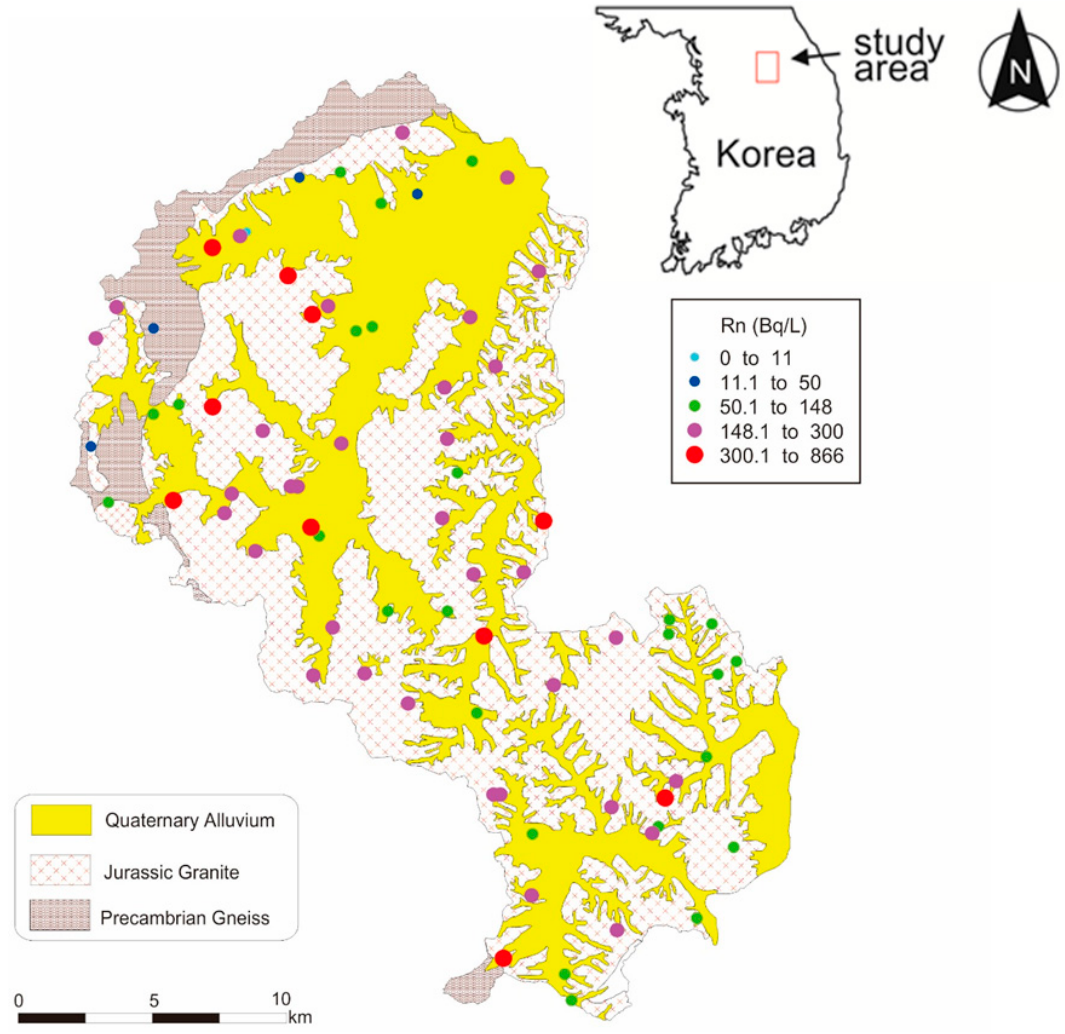
Figure 6. Spatial distribution of radon concentrations in groundwater on the geological map.